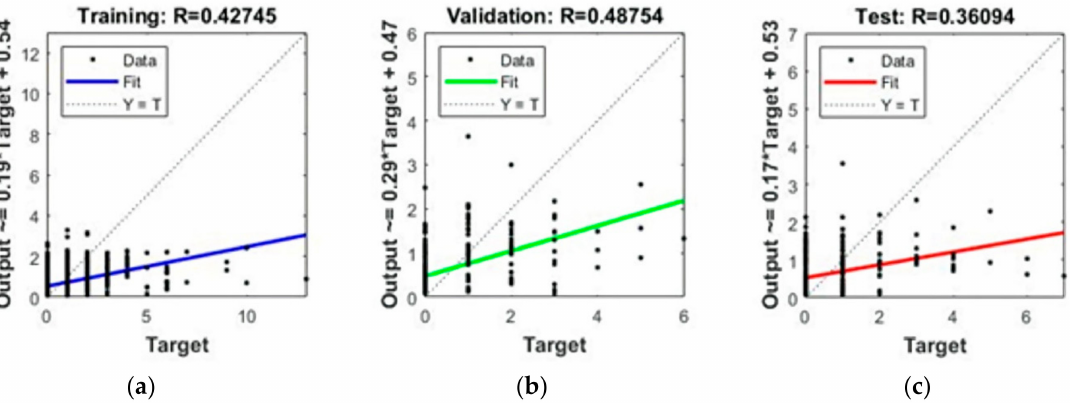
Figure 8. Cluster B model for crime occurrence prediction (layer: 4, node: 6); ( a ) Training data regression result; ( b ) Validation data regression; ( c ) Test data regression